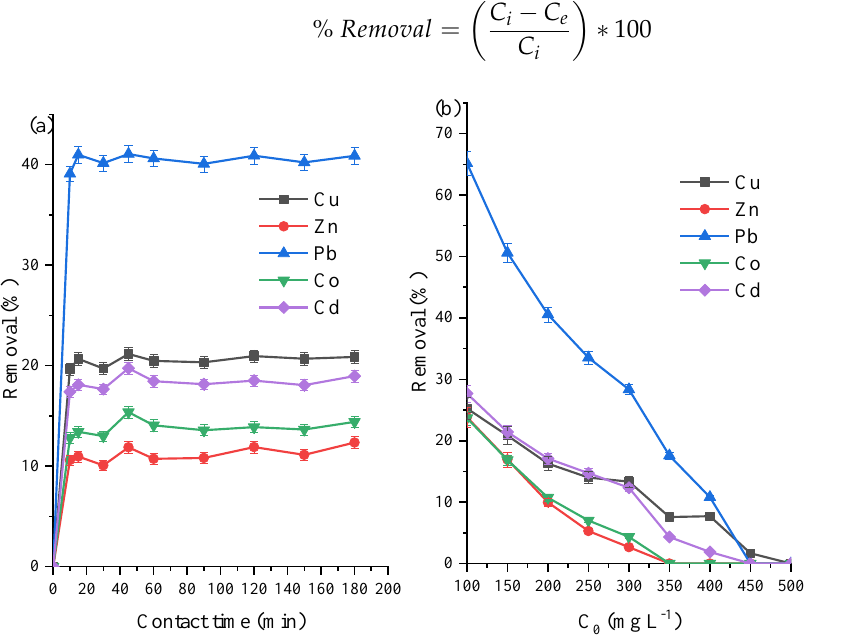
Table 1. XRF chemical compositions (wt%) of raw VK.